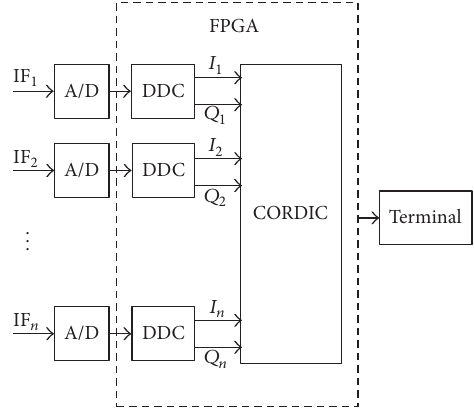
Figure 4: DBF module.